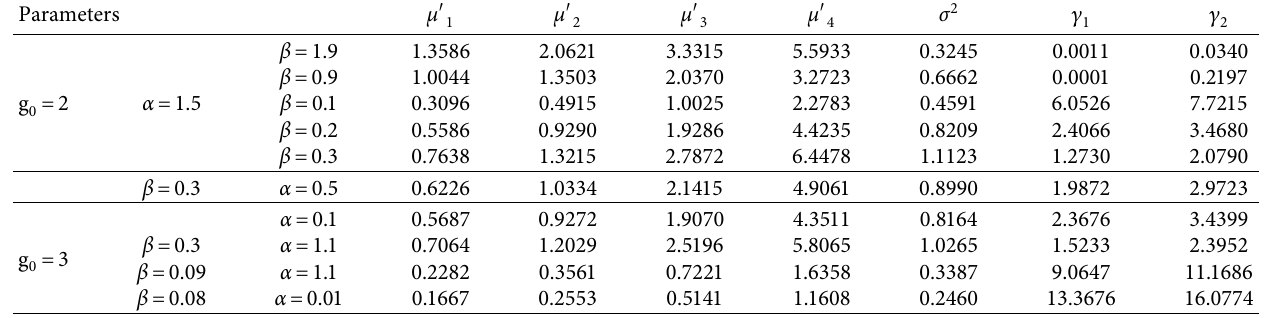
Table 1: Numerical analysis for moments, variance, skewness, and